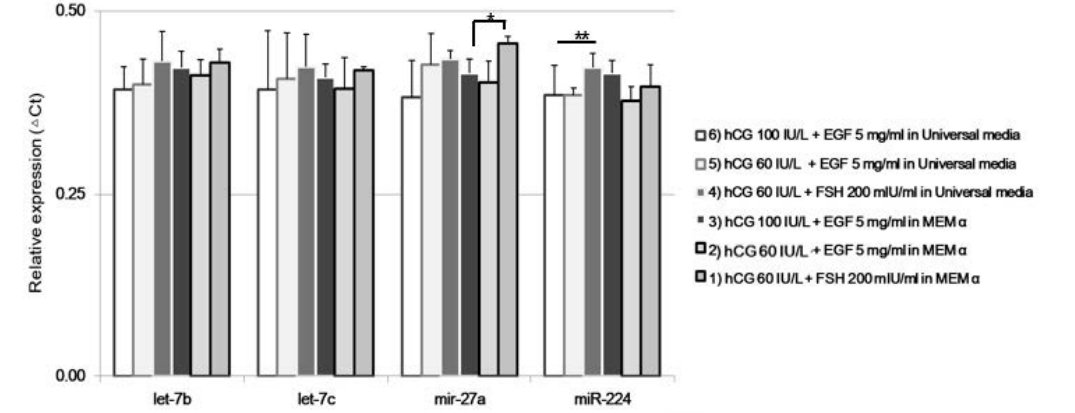
Figure 6. miRNAs expression of single marmoset oocytes from different in vitro maturation conditions. The expression of specific miRNAs, Cja-let-7b, Cja-let-7c, Cja-miR-27a , and Cja-miR-224 was analyzed at the single-cell level. * p < 0.05; ** p < 0.05